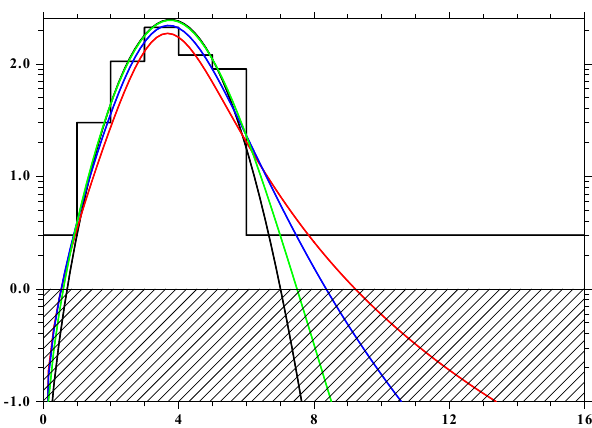
Figure 5. Sketch of a realistic situation for fitting the data (his- togram, i.e., currents in the instrument cups). The black line shows a shifted Maxwellian and three shifted κ distributions with κ = 1 . 6 (red), κ = 3 (blue), and κ = 10 (green). The numbers on the x axis are the channel numbers, which can be translated to energy or ve- locity. The y axis is in arbitrary units. The distribution functions are multiplied with the velocity, which is approximately a representa- tion of the currents; see Bridge et al.